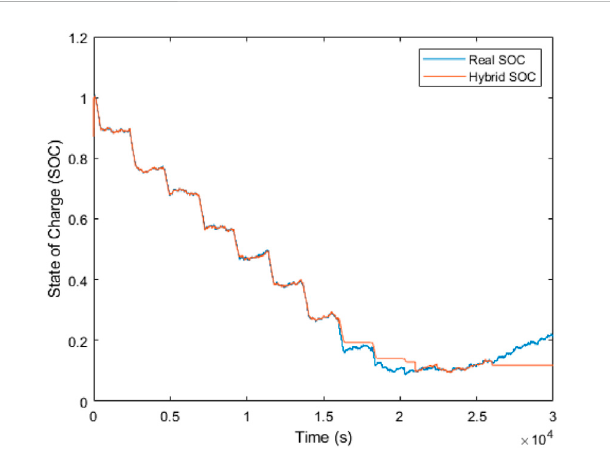
FIGURE 11 Hybrid estimator performance under noisy measurements.